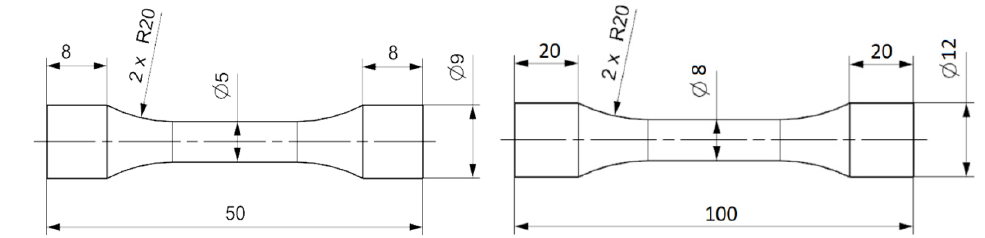
Figure 7. Geometry of the experimental specimens (in millimetres). AM— left ; cast— right .